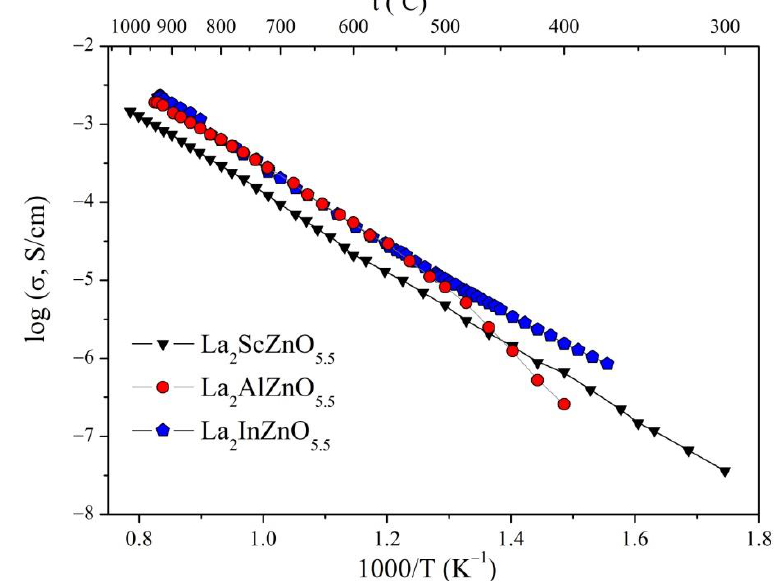
Figure 6. Temperature dependencies of the conductivities of La 2 ScZnO 5.5, La 2 AlZnO 5.5 [46], and La 2 InZnO 5.5 [47].